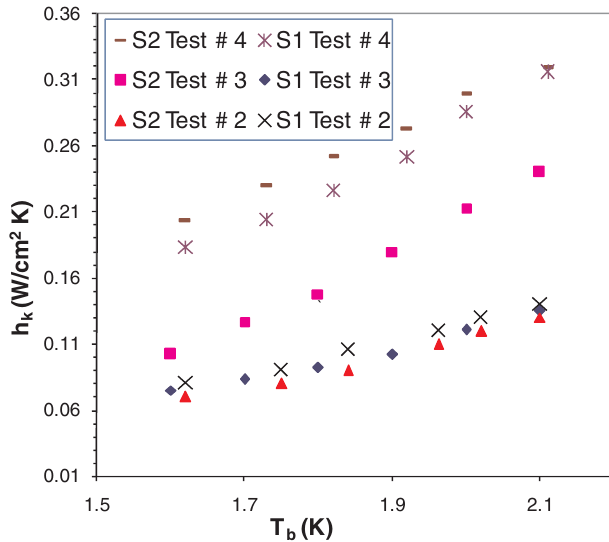
FIG. 17. (Color) Comparison of Kapitza conductance values of the two samples, S1 and S2, after titanification (test